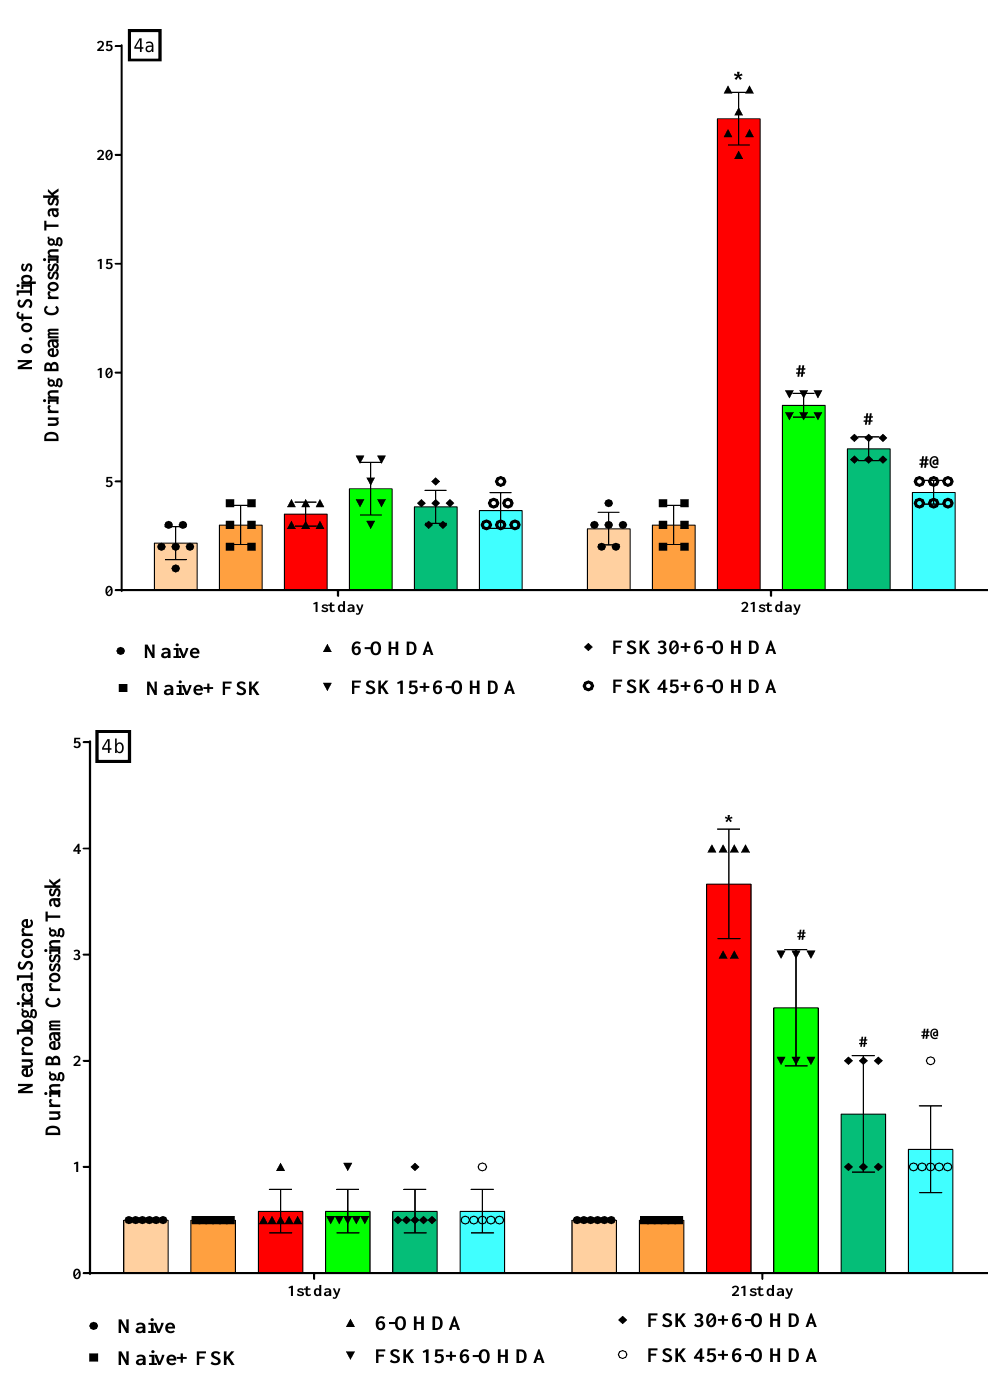
Figure 4. ( a ) FSK reduced the number of slips using the beam crossing task (BCT) in the experimental model of PD. Data provided as mean ± SD (n = 6 ) followed by ANOVA (two-way) with post-hoc Bonferroni test. * 6-OHDA ( p < 0.01) compared with naive and naive + FSK ; # FSK15, FSK30, FSK45 (p < 0.01 ) compared with 6-OHDA ; #@ FSK45 (p < 0.01 ) compared with FSK30, FSK15 . ( b ) FSK reduced the neurological score using the beam crossing task (BCT) in the experimental model of PD. Data provided as mean ± SD (n = 6 ) followed by ANOVA (two-way) with post-hoc Bonferroni test. * 6-OHDA ( p < 0.01) compared with naive and naive + FSK ; # FSK15, FSK30, FSK45 (p < 0.01 ) compared with 6-OHDA ; #@ FSK45 (p < 0.01 ) compared with FSK30, FSK15